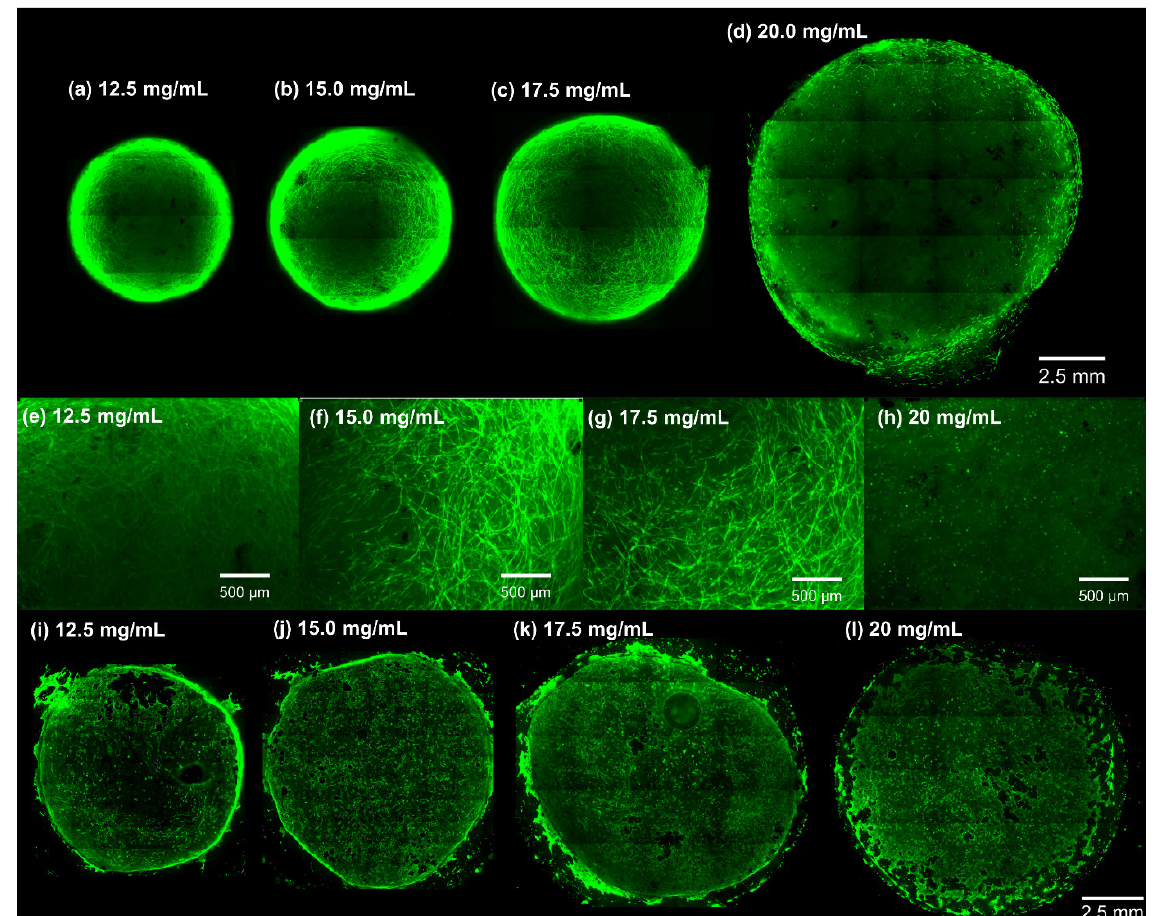
Figure 5. Viability assays of cells incubated inside and atop dECM hydrogels using Calcein AM dye. ( a – d ) The viability imaging of primary human fibroblast cells (HFLCs) after 5 days of culture within dECM. Hydrogels with concentrations <20 mg/mL underwent contraction, and their final diameter decreased significantly compared to their initial size. ( e – h ) Close up microscopy images of HLFCs cultured within dECM hydrogels. ( i – l ) The viability imaging of primary human bronchial epithelial cells after 4 days of culture on top of the dECM hydrogels’ surface.